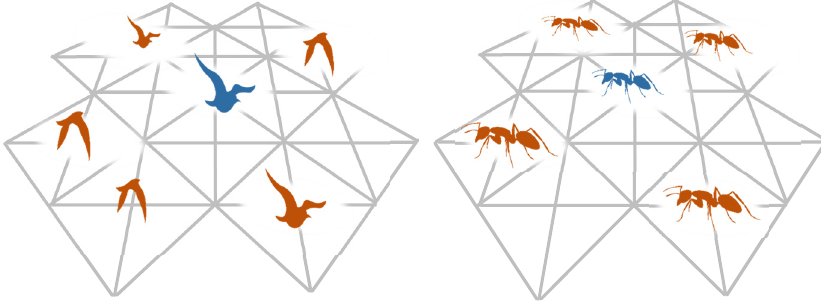
Figure 1. Examples of swarm intelligence in nature and information flow among individuals.